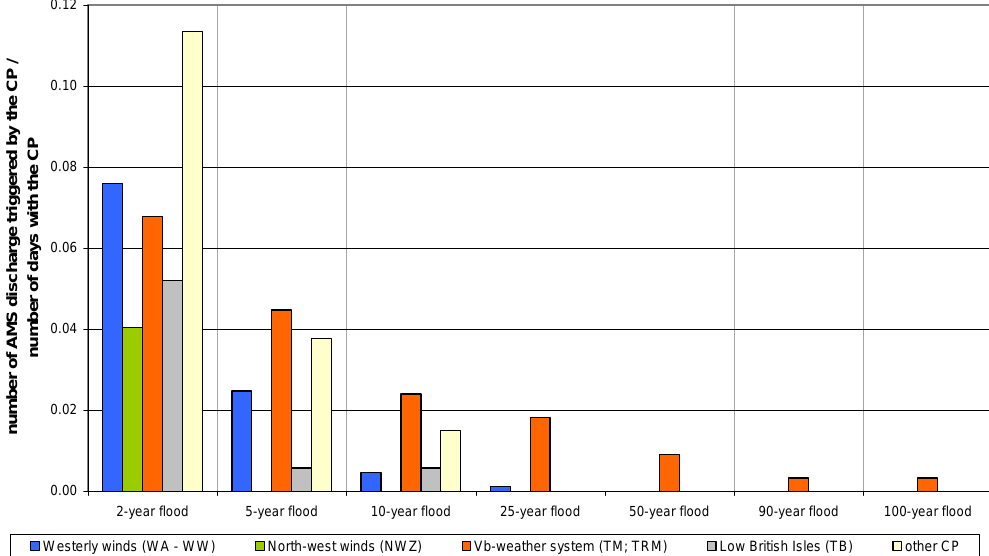
Fig. 10. Flood potential of different circulation patterns to cause a flood of a certain return period generated by several different CPs, though mainly by west- erly cyclones (WA–WW), north-east cyclones (NEZ) and the troughs over central Europe (TM, TRM). Figure 9 illustrates the distribution separately for summer and